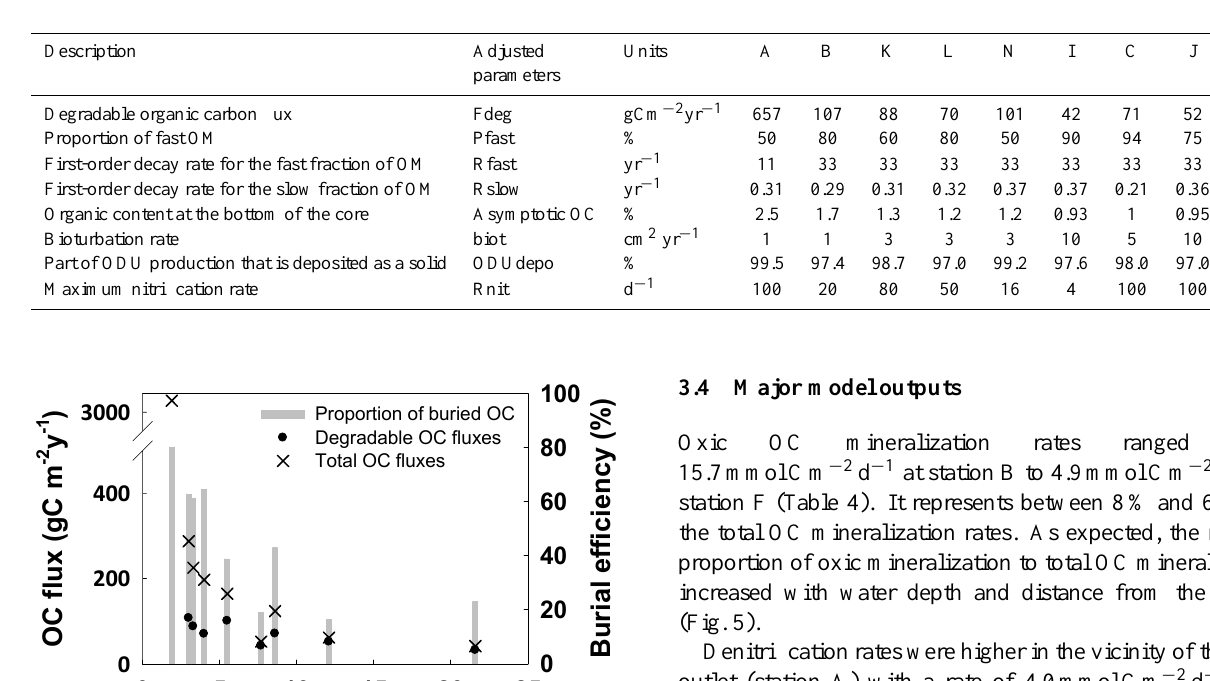
Table 3. Adjusted parameters.